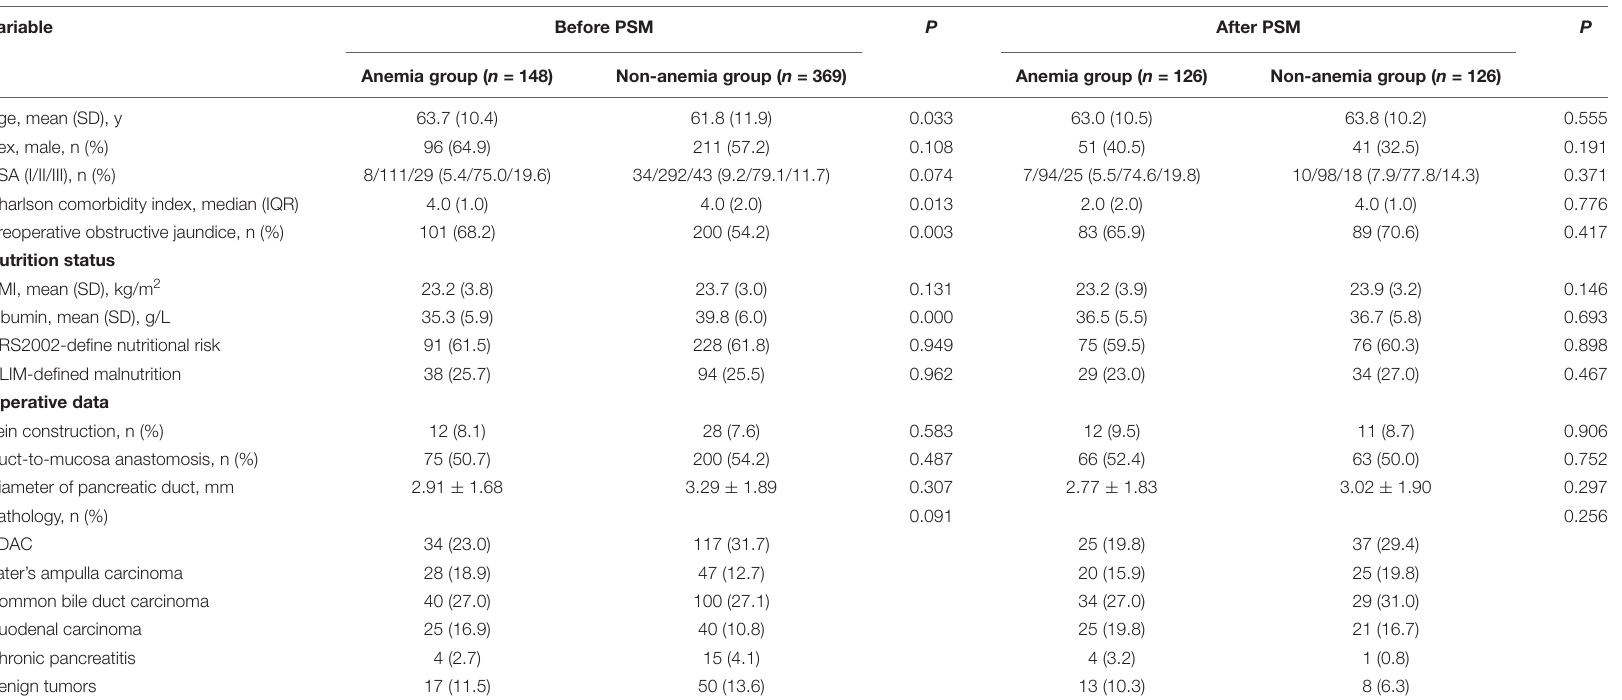
TABLE 1 | Basal data comparison between anemia and no anemia groups. Variable Before